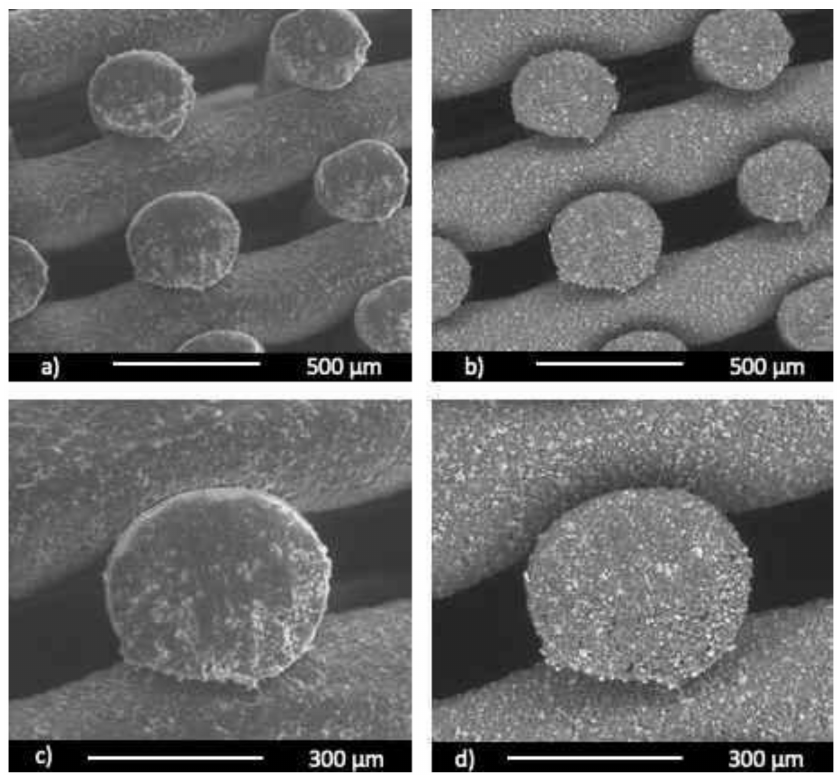
Figure 3. Representative SEM images of a cross-section view of the 50/50 scaffold: ( a , c ) secondary electron detector; ( b , d ) backscattered electron detector.